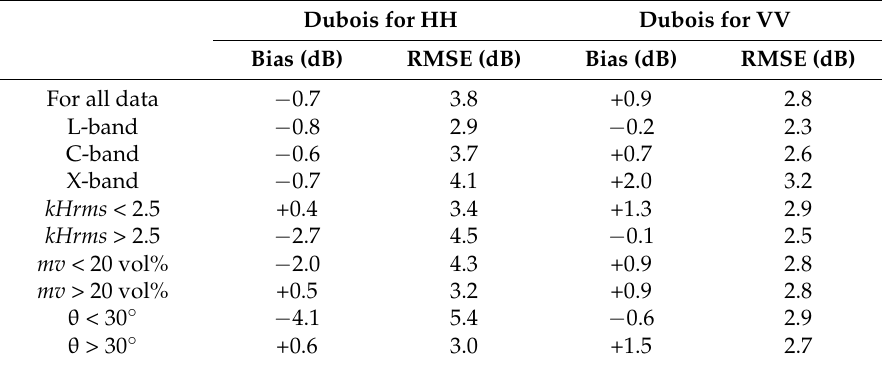
Table 2. Comparison between the Dubois model and real data for all data and by range of kHrms , soil moisture ( mv ), and incidence angle ( θ ). Bias = real data − model. Dubois for HH Dubois for VV Bias (dB) RMSE (dB) Bias (dB) RMSE